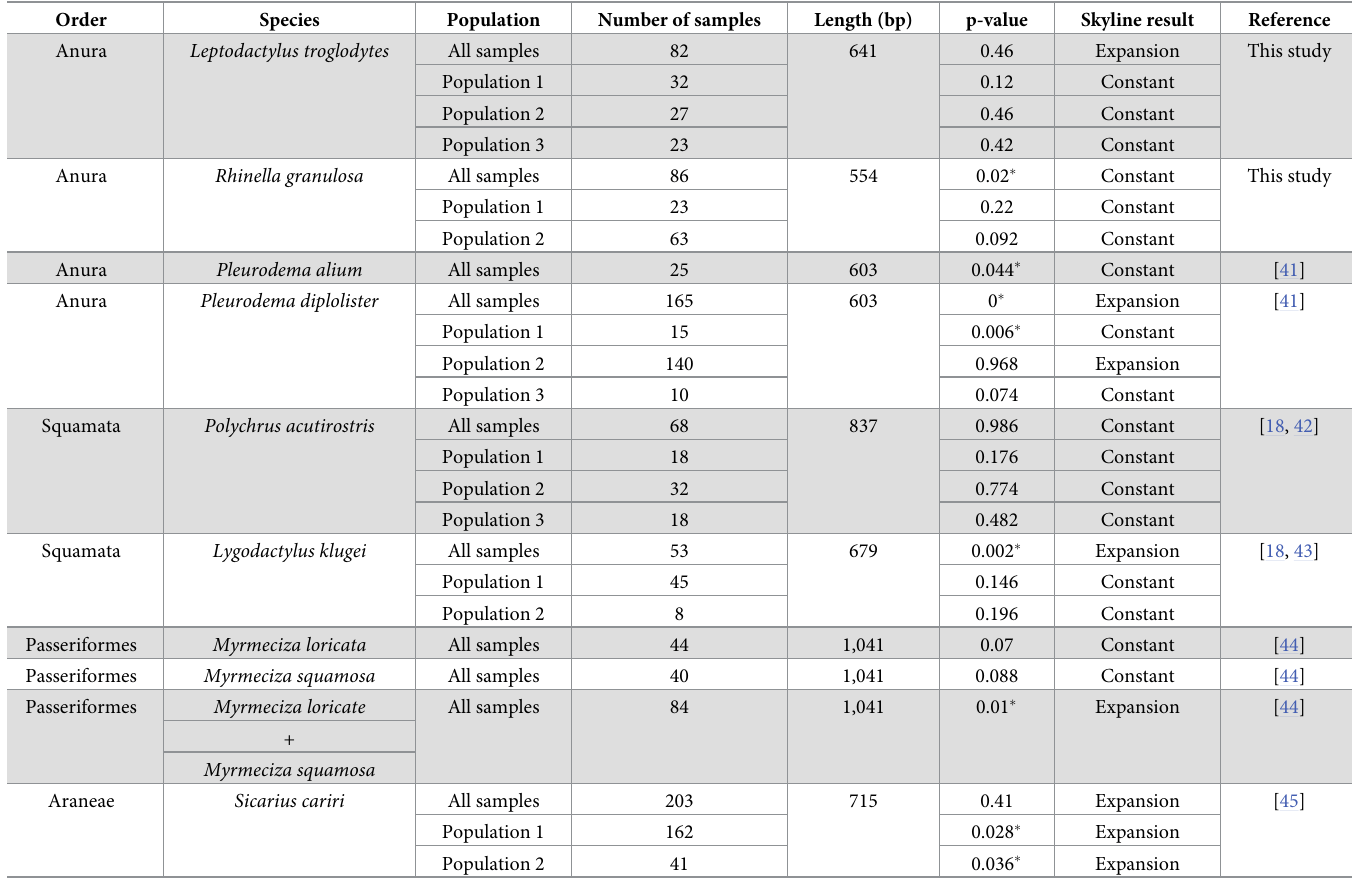
Table 2. Results of the P2C2M.Skyline on empirical datasets. Asterisk indicates datasets with p -value <